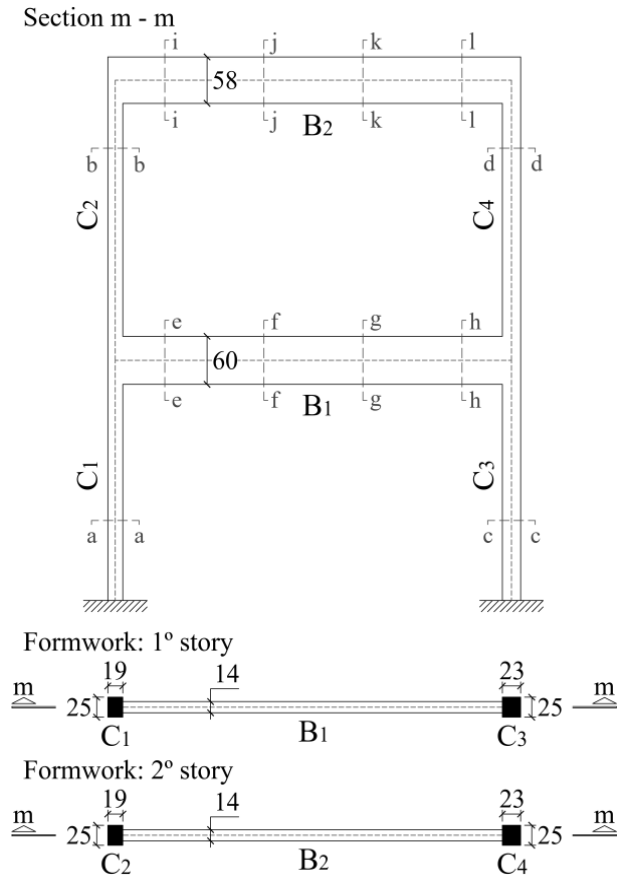
Figure 7. Optimal structure (dimensions in cm) - Example I: case I.